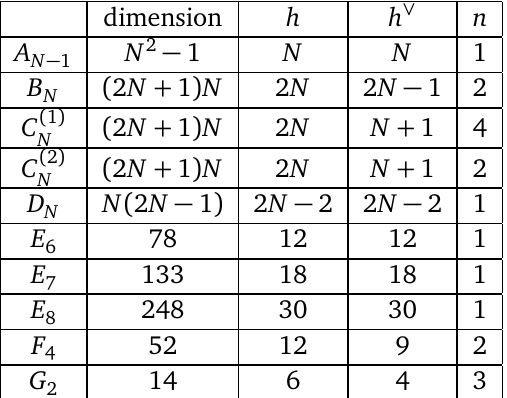
Table 4: Lie algebra data. h is the Coxeter number and h ∨ is the dual Coxeter number.